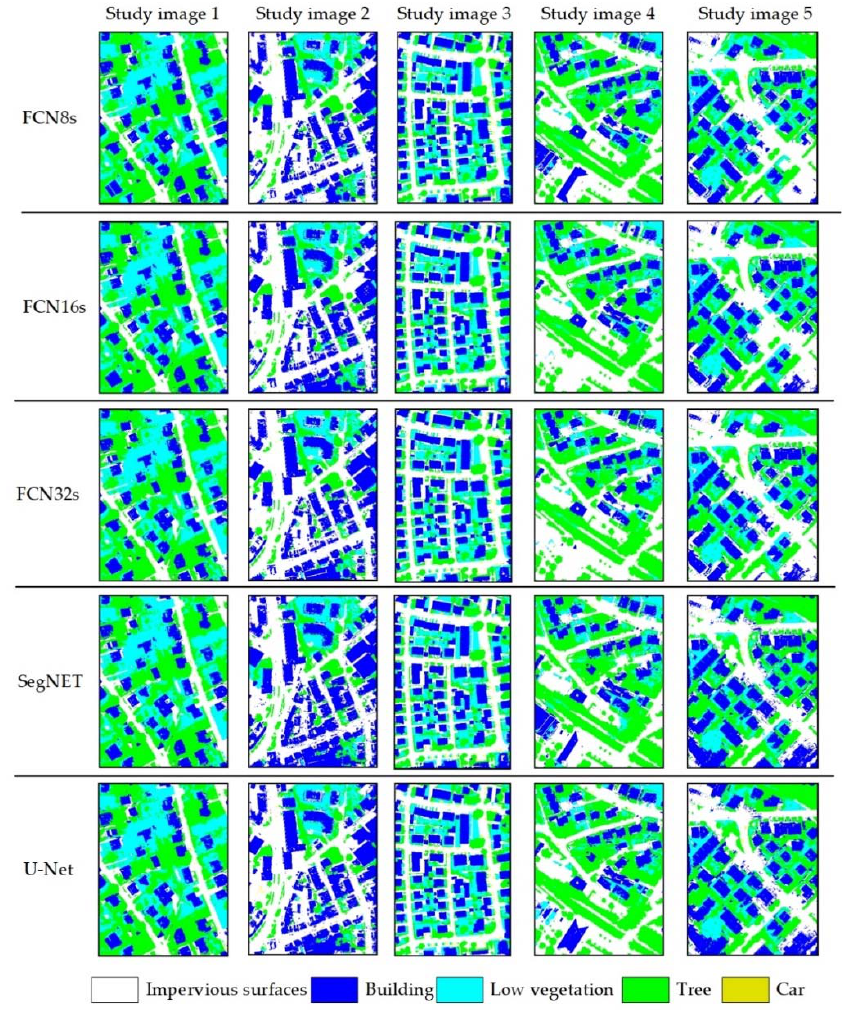
Figure 8. CRF correction results.